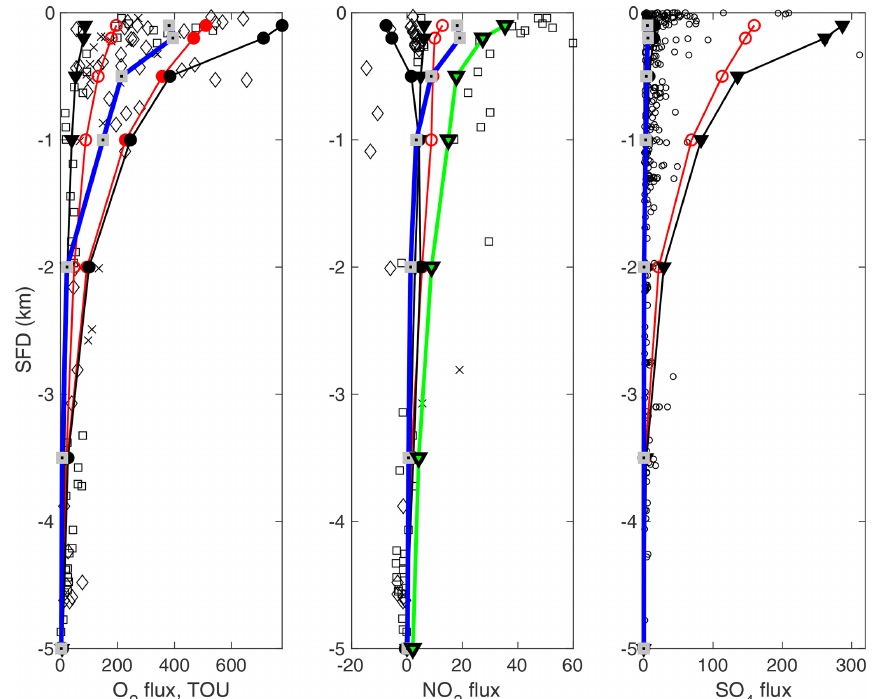
Figure 4. Simulated (lines) and observed (points) benthic fluxes of O 2 , NO − and SO 2 − along a global hypsometry transect. Flux units are in 3 4 µmol cm − 2 yr − 1 . OMEN-SED-RCM (blue lines with grey squares) are compared to simulation results from the numerical diagenetic model BRNS (red lines with open symbols, Thullner et al., 2009); and results from the analytical diagenetic model OMEN-SED (black lines, • : = γ = 0 . 95; (cid:72) : γ NH = γ = 0 . 05), Hülse et al. (2018). The red line with filled circles indicates total oxygen uptake simulated γ NH H 2 S H 2 S 4 4 by Thullner et al. (2009). The green line indicates OMEN-SED-RCM simulations that were forced with boundary conditions and N : C values that are more representative of the eastern Pacific Ocean. Observed data of O 2 and NO − fluxes from the Atlantic (diamonds), Pacific 3 (squares) and Arctic/Indian oceans (crosses) are from Middelburg et al. (1996), while SO 2 − data (circles) are from Egger et al. 4